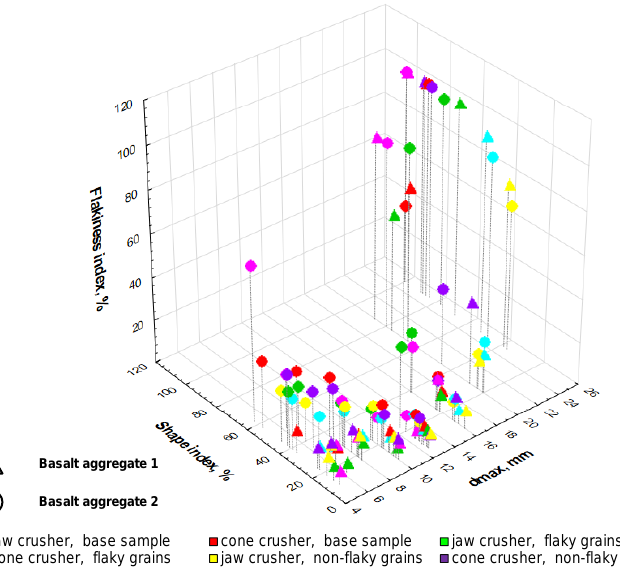
Figure 7. Three-dimensional distribution characteristics of geometric parameters in grain classes.